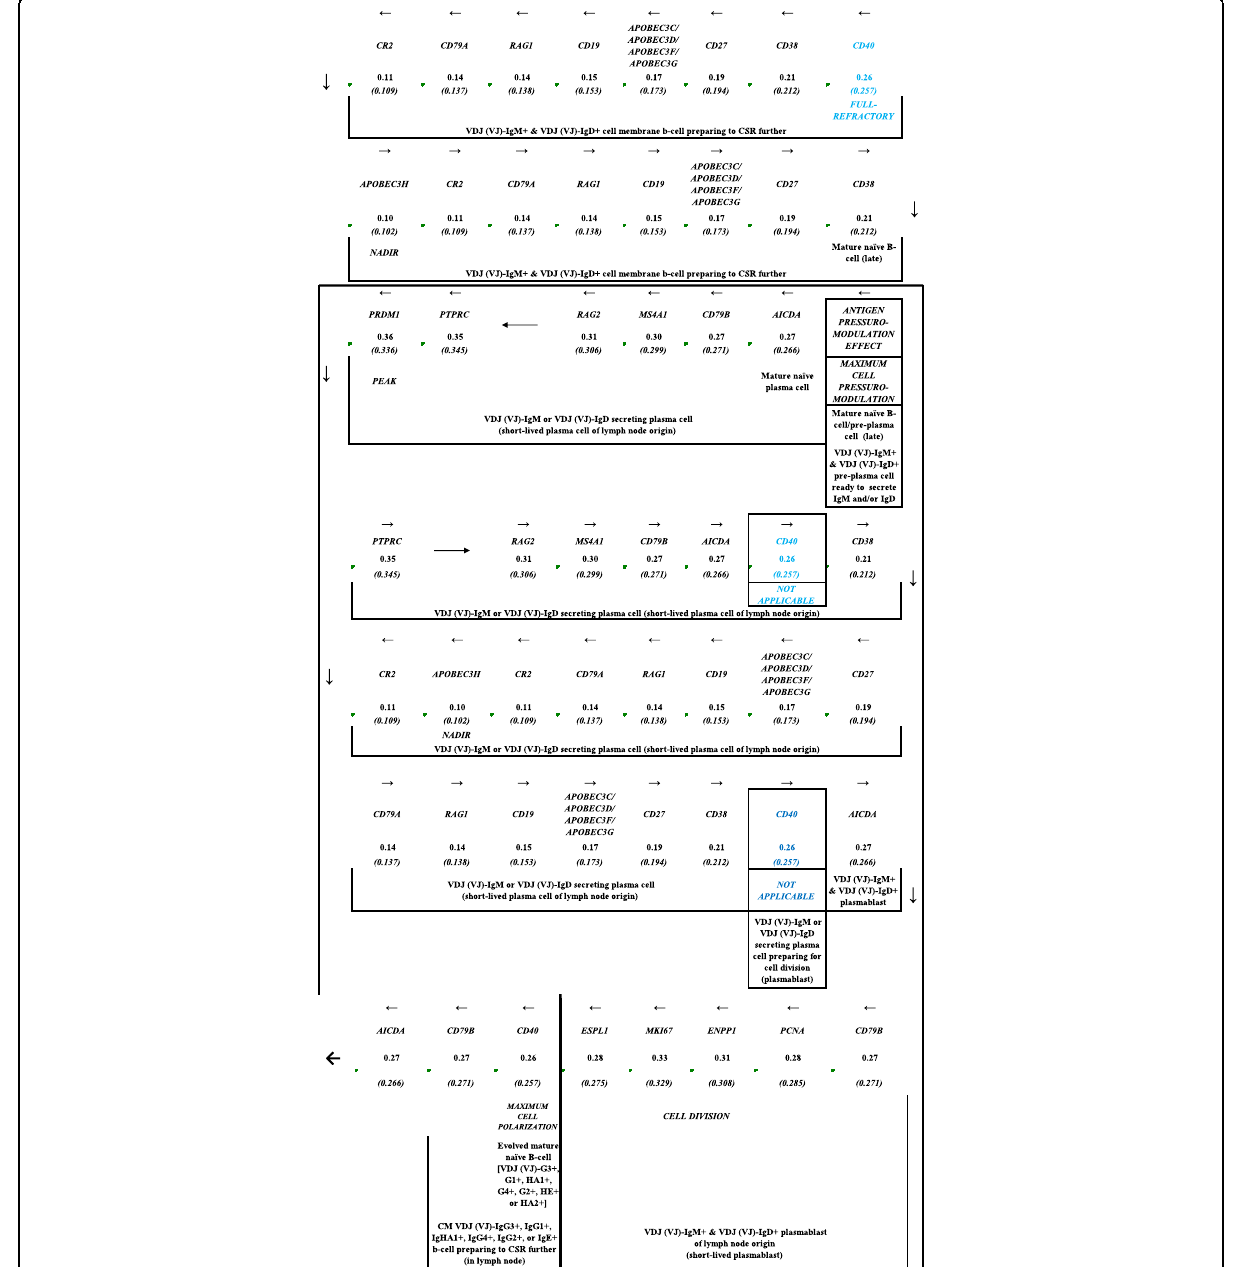
Fig. 2 Allele 2 (IGHD) 1-step and 2-step Ig heavy chain locus gene rearrangement recombination steps superimposed on the pressuromodulation map of B-cell differentiation stages. The Allele 2 one-step recombination step is IGHD_-_ and IGHJ1, IGHJ2 or IGHJ3 recombination that results in IGHD_-_ - IGHJ1 -J2 or -J3 (step 1 of 1) through the final IGHV_-_ and IGHD_-_-IGHJ1, IGHD_-_-IGHJ2 or IGHD_-_-IGHJ3 recombination that results in V_-_-DJ6 . The Allele 2 two-step recombination steps are IGHD1 – 14 (nf) or IGHD5 – 18 (nf) and IGHJ2 recombination (step 1 of 2), the IGHD_-_ genes with respect to D1 – 14 (nf)-J2 or D5 – 18 (nf)-J2 (step 2a of 2) and the IGHJ4 with respect to D1 – 14 (nf)-J2 or D5 – 18 (nf)-J2 (step 2a of 2) recombin- ation that results in IGHD_-_ - IGHJ4 (step 2b of 2) through the final IGHV_-_ and IGHD_-_-IGHJ4 recombination that results in V_-_-DJ6 . Note: Allele 2 Ig locus rearrangement recombination follows that of Allele 1 and always completes to the point of VDJ rearrangement in the marrow. In the classical pathway, homologous recombination or initial allelic exclusion followed by delayed Allele 2 iCSR (i.e. CM IgM+ IgD+) are the rule in the lymph node. In the non-classical pathway, Allele 2 locus recombination completes to the point of VDJ rearrangement (i.e CM IgM+ only). † , upper esebssiwaagoT Q units range, 0.41 – 0.36. Black, CD40 at maximum cell polarization potential. Dark blue, CD40 at half-refractory. Light blue, CD40 at full-refractory. Text boxes with complete borders, 2-step. Text boxes with dashed borders, 1-step. Large rectangular box with complete borders, extra-nodal secretory antibody